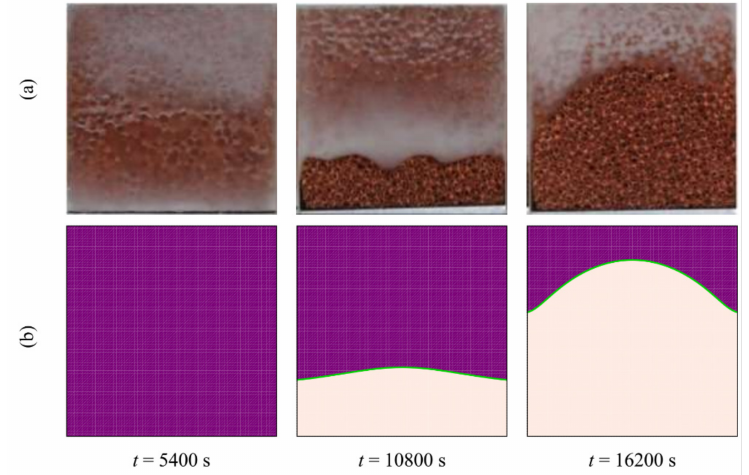
Figure 5. ( a ) The experimental observations of [52]; and ( b ) the numerical outcomes of the present investigation.